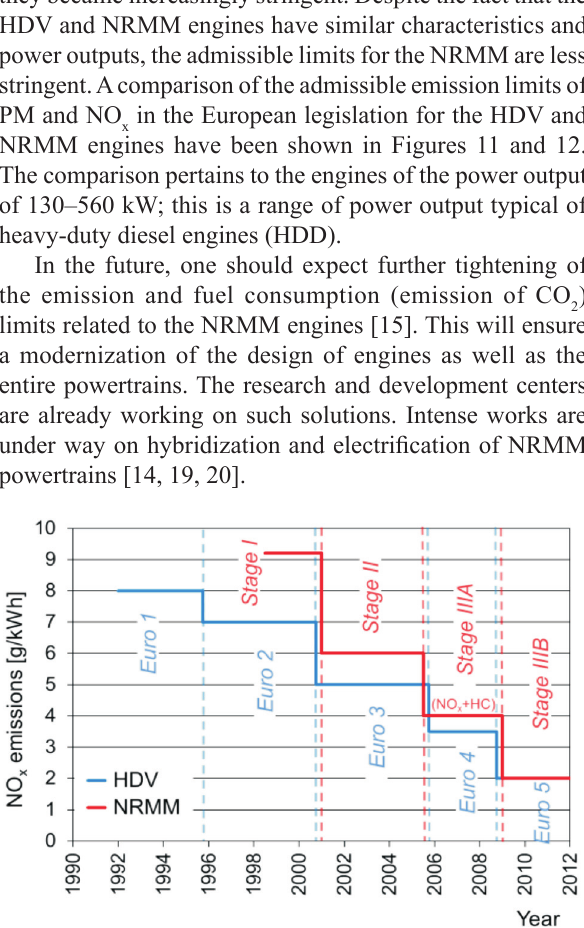
emission for the x